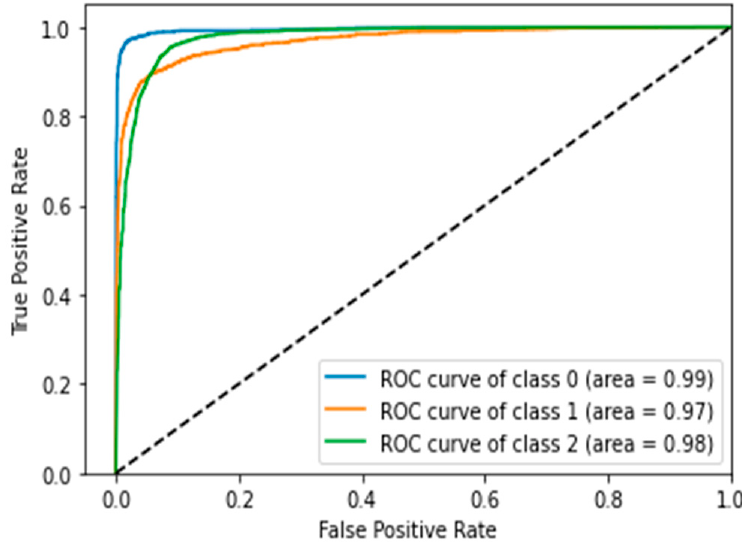
Figure 14. ROC curve for Custom-Model. The ROC curve for MobileNetV2 is shown in the Figure 15.